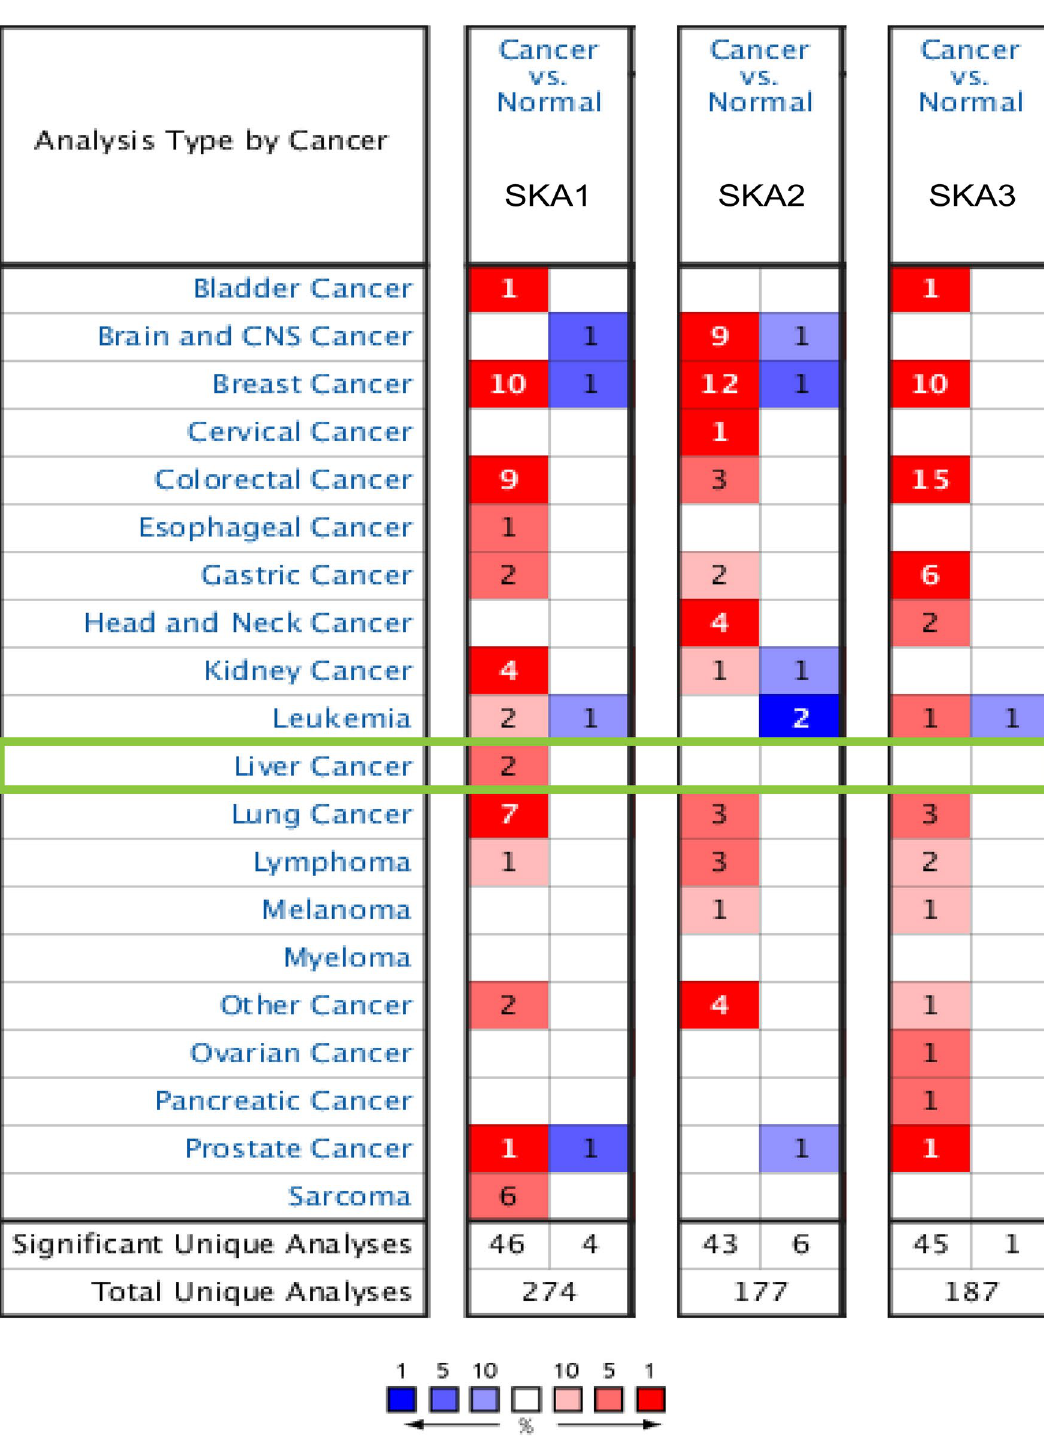
Figure 1. mRNA expression levels of SKAs in different types of human cancer (Oncomine). Red indicates high expression. Blue indicates low expression. P < 0.05, fold-change > 2 and gene rank = 10% were considered statistically significant. Numbers in each cell represent the data set meeting the threshold. SKA spindle and kinetochore-associated